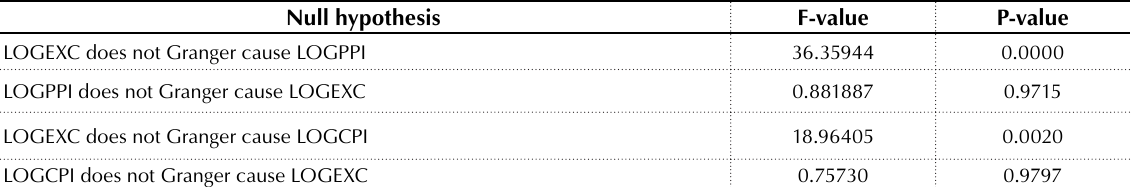
Table 7. Granger causality test